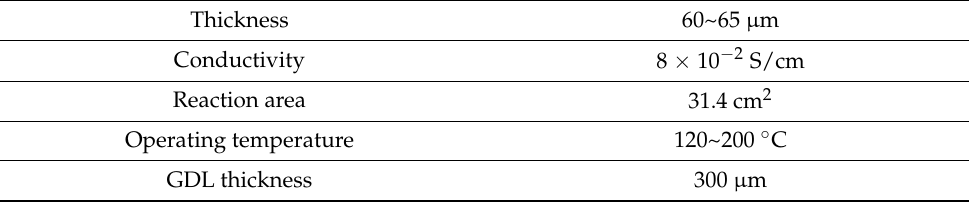
Figure 9. Commercially purchased high temperature MEA. Table 1. Commercial Advent TPS ® MEA detailed specifications.